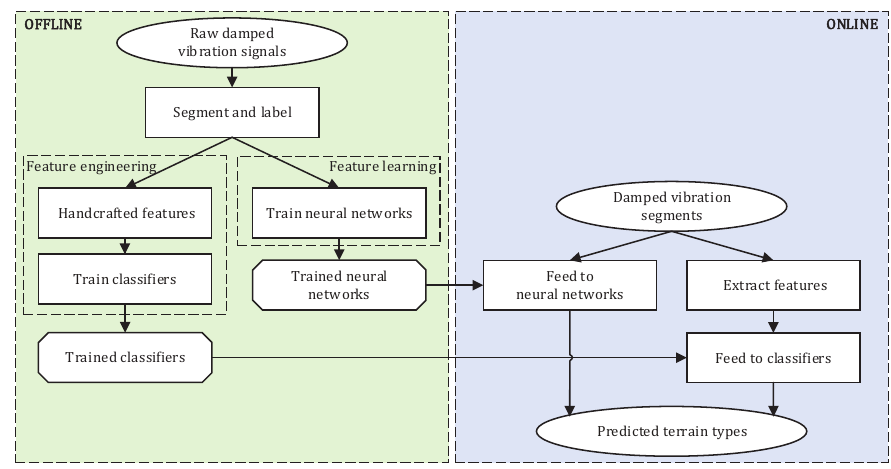
Figure 2. Illustration of dampened vibration-based terrain